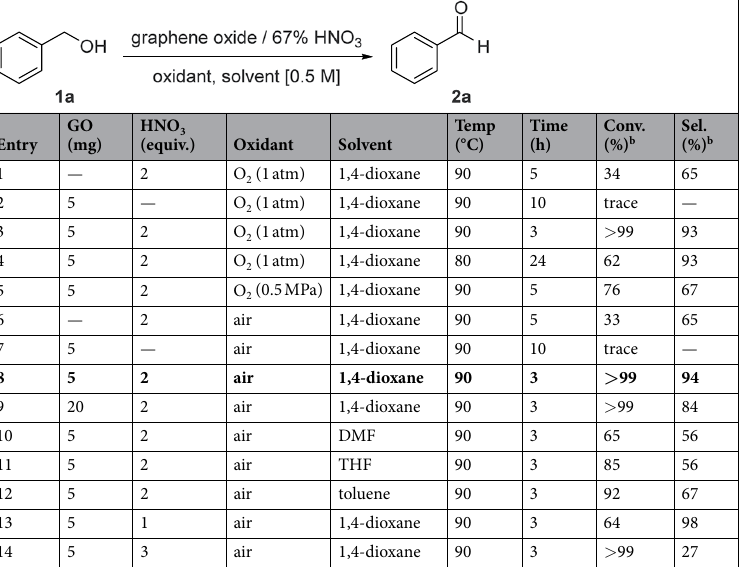
Table 1. Optimisation of reaction conditions for graphene oxide-catalysed oxidation of benzyl alcohol to benzaldehyde using HNO 3 under an oxygen/or air atmosphere a . a Reaction conditions: 1a (1 mmol),